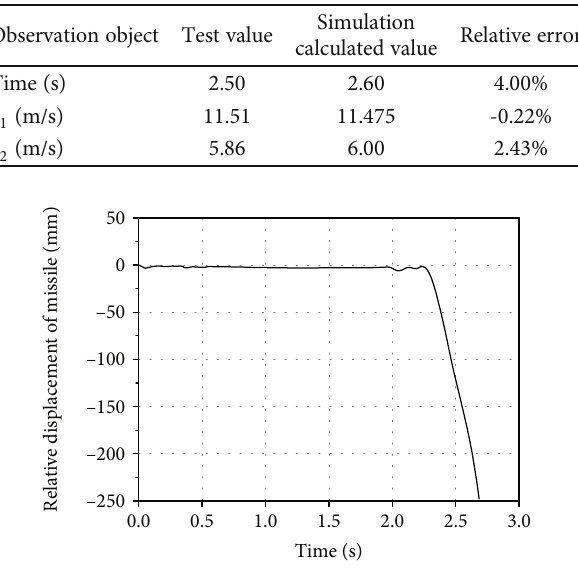
Figure 16: Longitudinal relative displacement of the missile centroid under the fl uctuating platform.